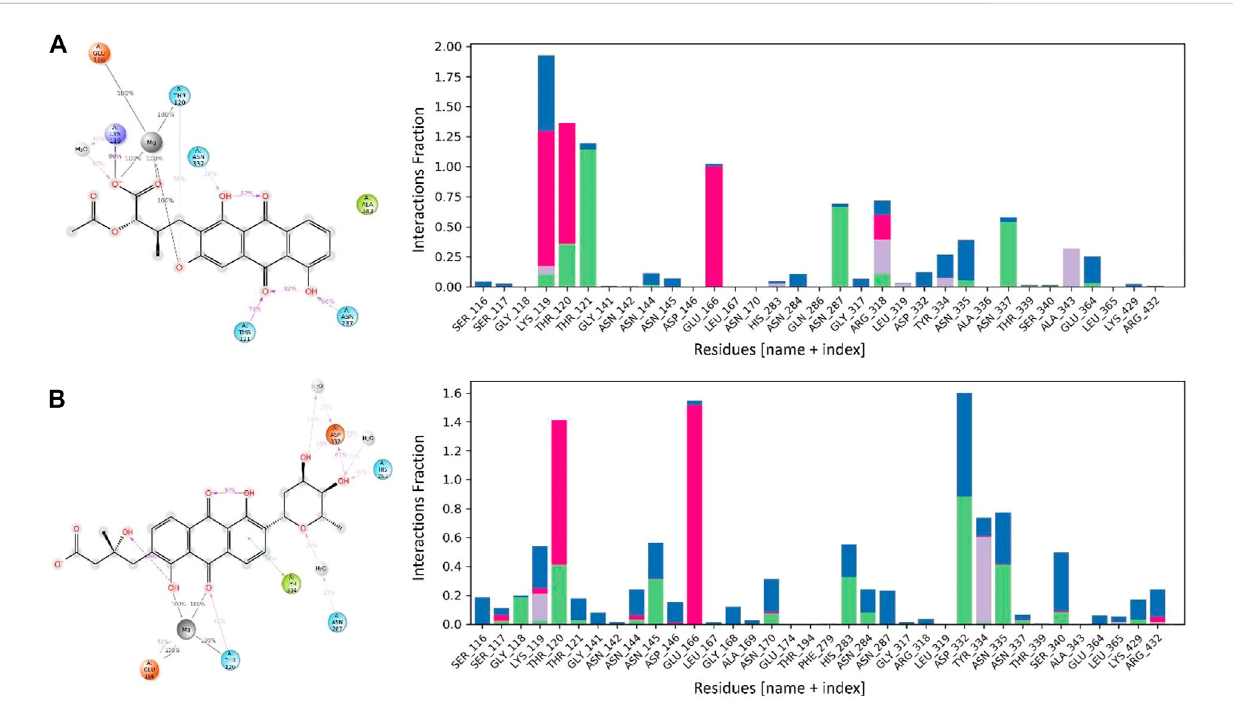
FIGURE 7 The interaction patterns and the fraction of MurF protein in complex with (A) Termstrin B and (B) Fridamycin A through the simulation period. The Histogram plot shows the fraction interaction of each residue, and the colour codes show the type of interaction, i.e., the green colour represents hydrogenbonds,thegreycolourrepresentshydrophobicinteractions,thepurplecolourrepresentsionicinteractions,andthebluecolourrepresentsthe water